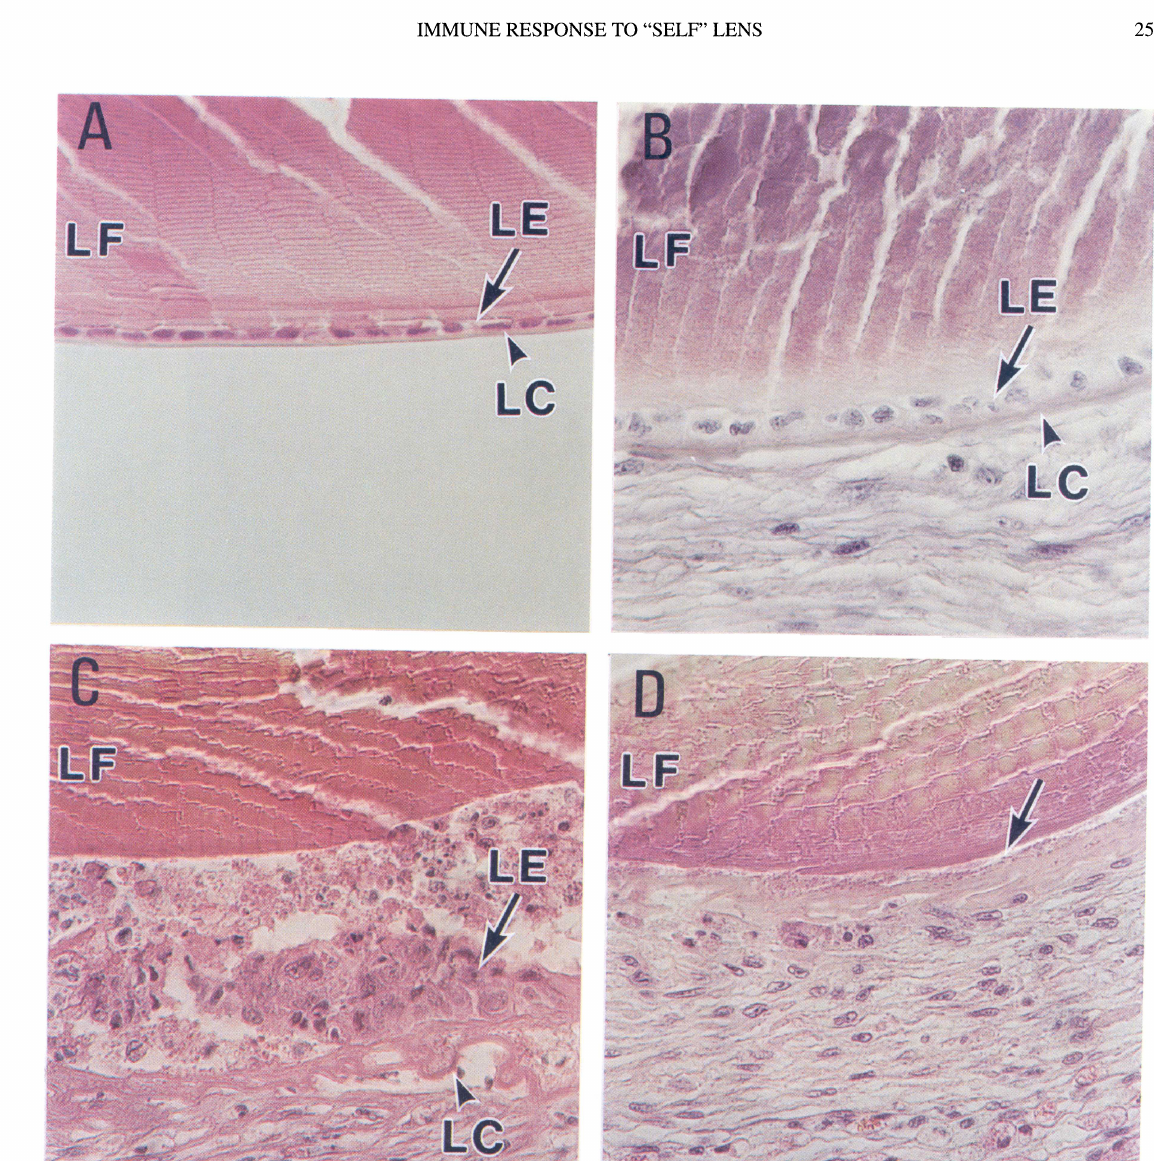
FIGURE 2 Histological status of the transplanted lenses. (A) Intact lens before transplantation consists of the lens epithelium (LE: arrow), lens capsule (LC: arrowhead), and lens fiber (LF). Damage to the transplanted lens was defined histologically as follows. (B) No damage: The transplanted lens is embraced by fibroblasts, but no damage is observed histologically in the lens. Few leukocytes are accumulated. (C) Destruction of the lens epithelial cells: Inflammation with lymphocytes and other leukocytes is observed around the transplanted lenses. Many leukocytes migrate between the up lifted lens capsule (arrowhead) and lens fiber. The lens epithelial cell layer detached from the lens fiber is fragmented and stratified. The nuclei of the lens epithelial cells are swollen. (D) Disappearance of lens epithelial cells: The lens epi- thelial cells have disappeared completely. The arrow represents the place where the lens epithelial cells should exist in a normal lens. In some cases, inflammatory cell accumulation is still observable at this stage. (Bar, 50 micrometer). (see colour plate II at the back of this issue)